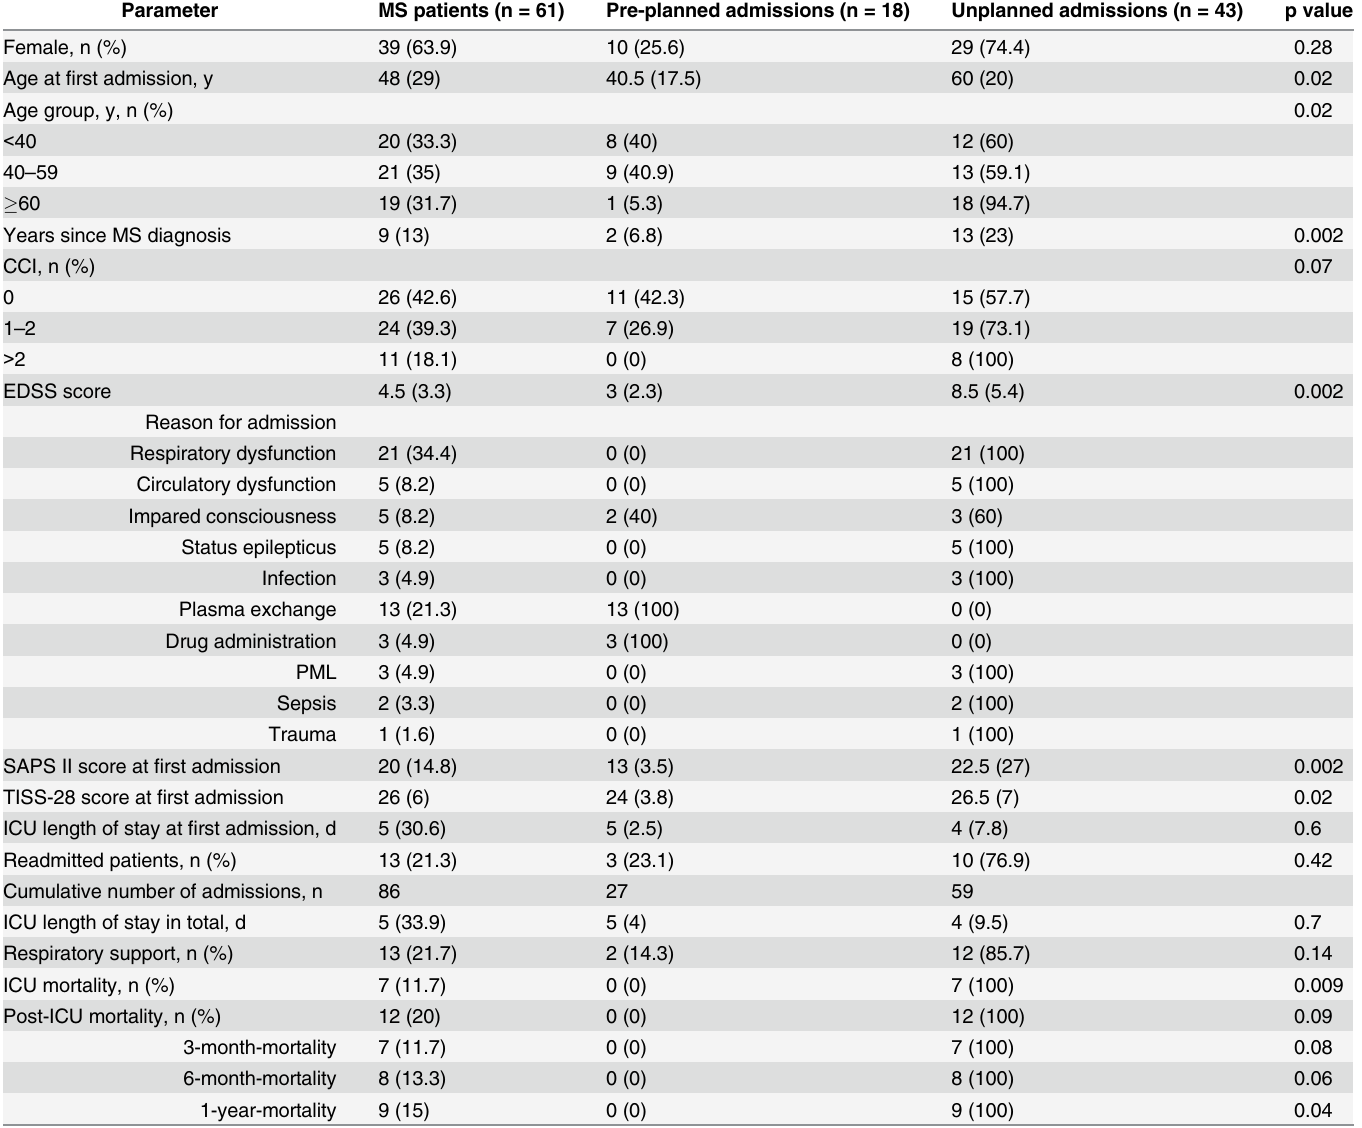
Table 1. Reasons for ICU admission and clinical characteristics of patients with